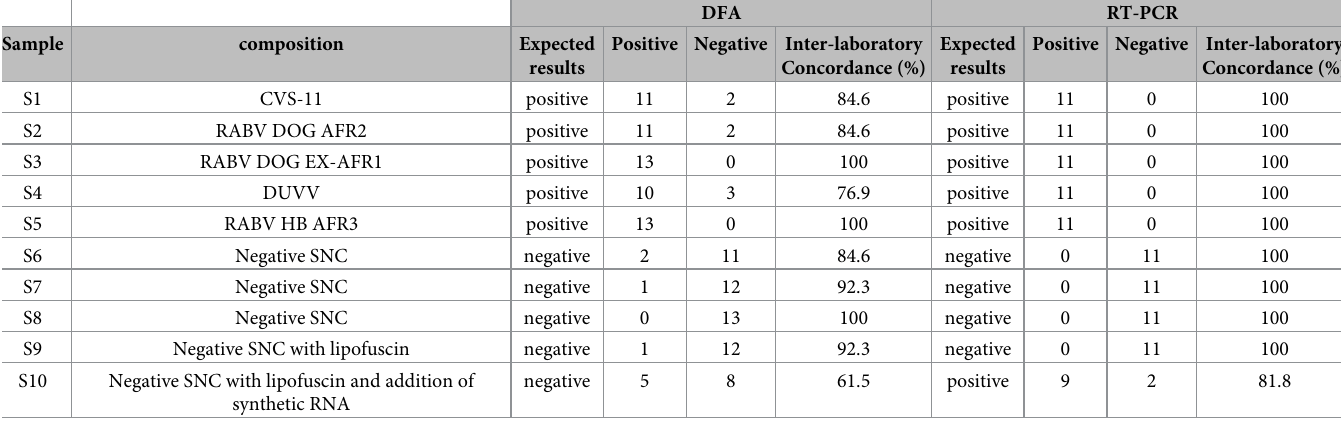
Table 4. Overall performances. The table summarizes the composition of each sample, the expected results and the performances of participants. Expected results for S10 is negative by fluorescent antibody test but positive by molecular testing. Out of fourteen laboratories, thirteen (13/14) submitted results by the DFA test and eleven (11/14) submitted results by conventional